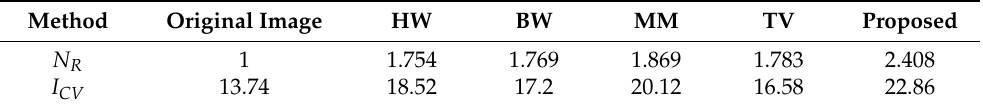
Table 3. Evaluation of MMS data processed by different